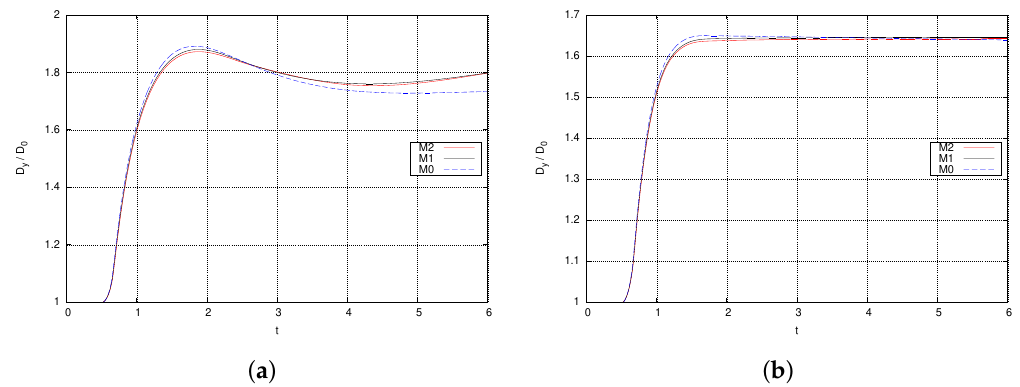
Figure 3. Vertical diameter as function of the time: Carbopol ( a ) and Kaolin ( b ).